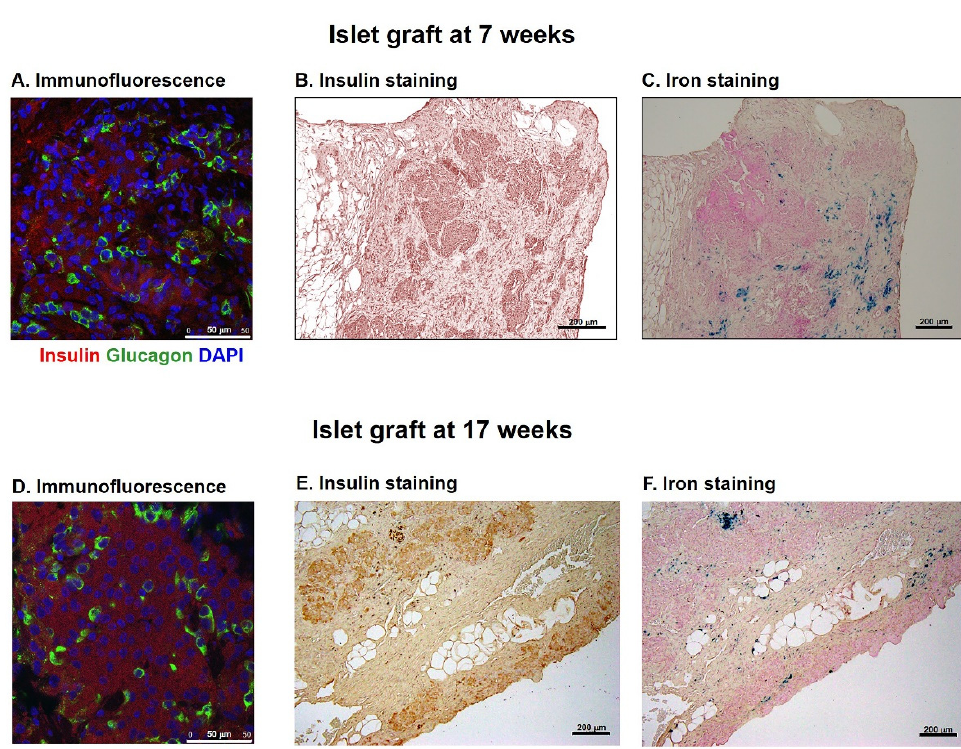
Figure 10. Histology of the MnMEIO-Ex4 NP-labeled islet graft removed at 7 ( A – C ) and 17 weeks ( D – F ) after transplantation. ( A , D ) Immunofluorescence staining of insulin (red color) and glucagon (green color) in islet grafts. ( B , E ) Grafts were stained with insulin (brown color). ( C , F ) Grafts were stained with Prussian blue (blue color).